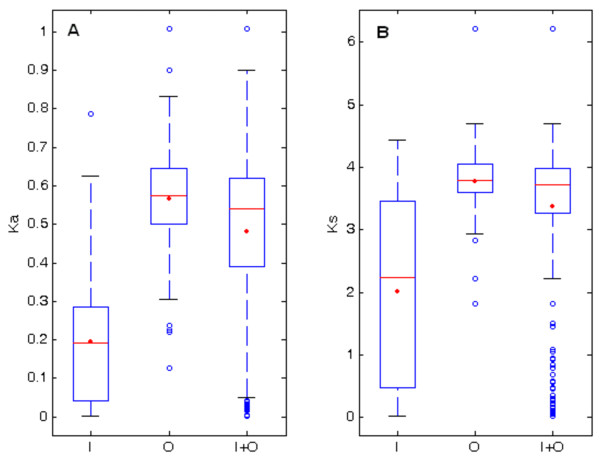
Whisker box plots detailing the variation in Ka and Ks for in-paralogs (I), out-paralogs (O), and all paralogs (I + O). The distributions of Ka (panel A), and Ks (panel B) are shown as box plots with the box representing the interquartile range (25%–75%), the thick solid horizontal line indicating the median, the dot indicating the mean, and the circles indicating the outliers. The plots illustrate and confirm that in-paralogs and out-paralogs possess different distributions of Ka and Ks values.